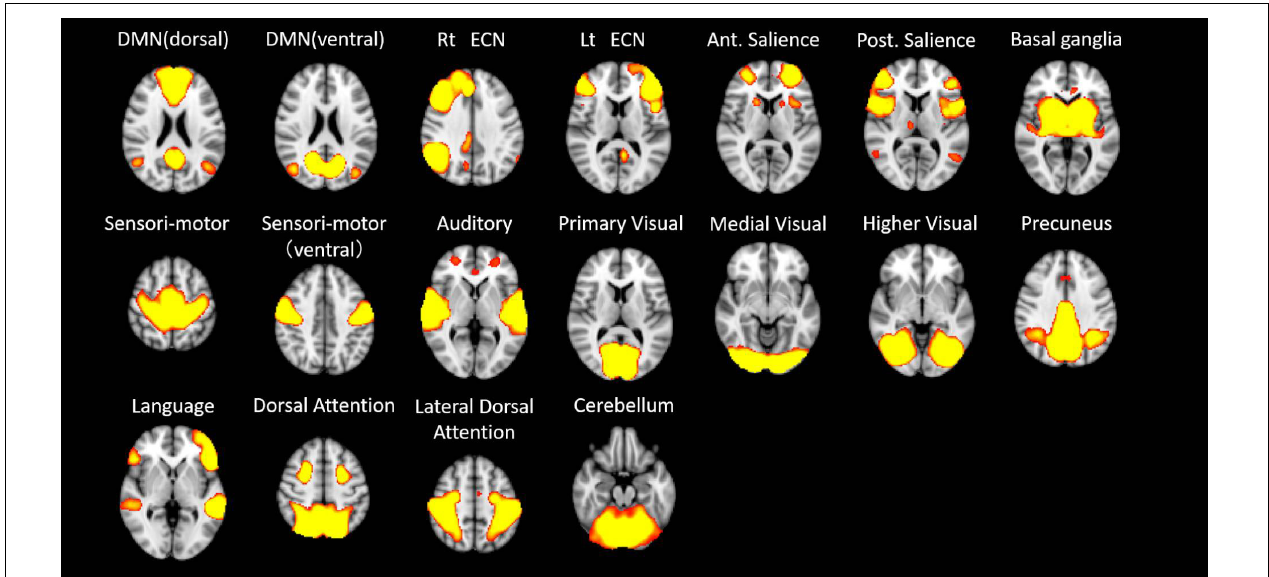
FIGURE 4 | The 18 resting networks extracted at the first step of the dual regression analysis. DMN – default mode network; ECN – executive control network; Rt – right; Ant – anterior; Post – posterior.